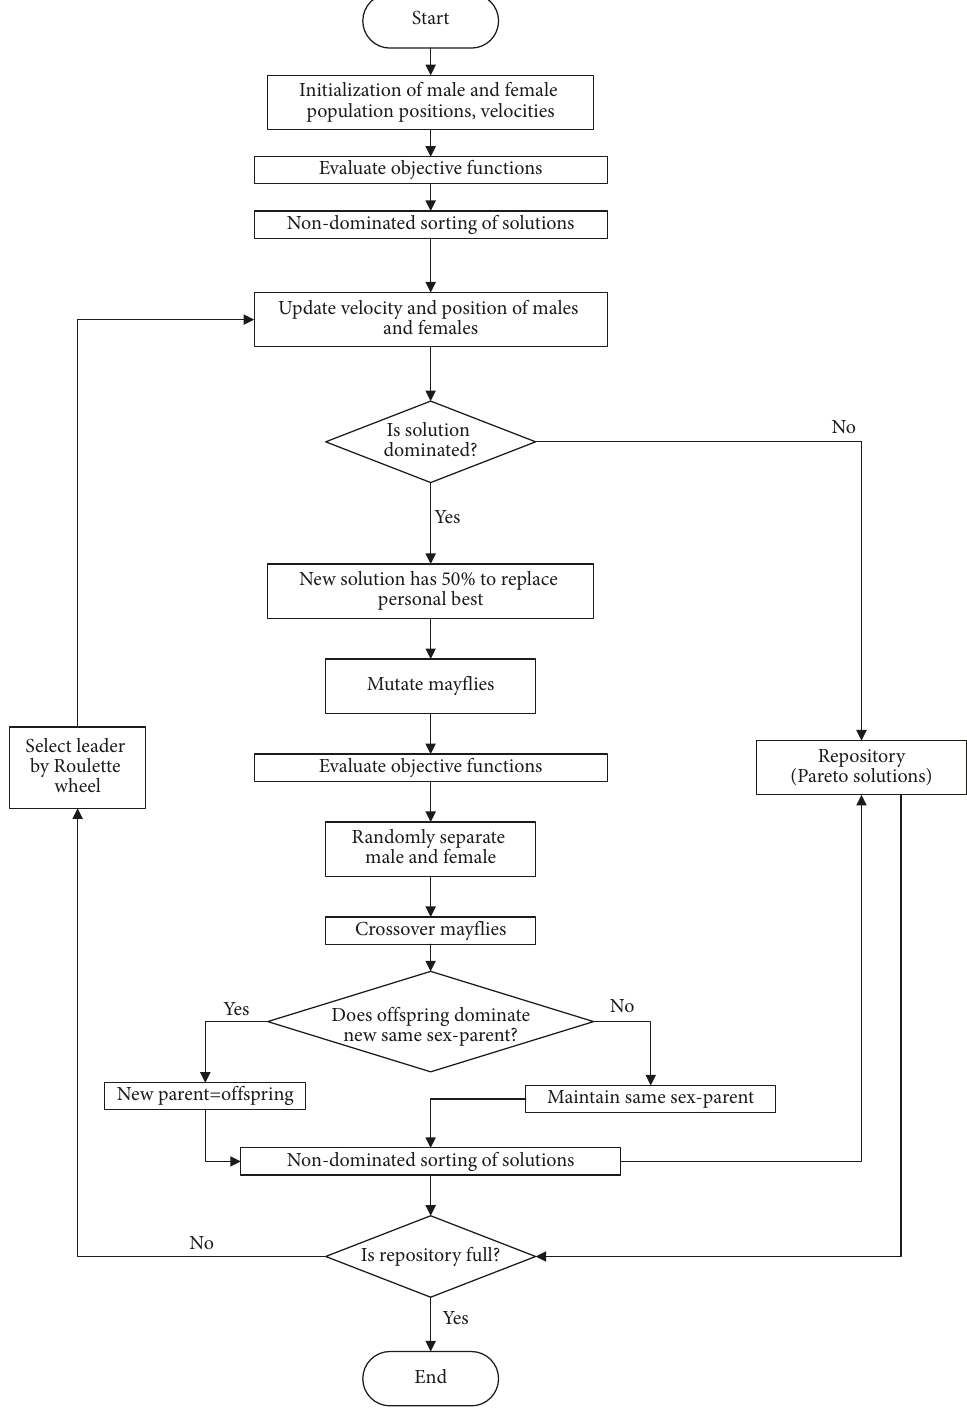
Figure 3: Flow chart of multiobjective mayfly algorithm